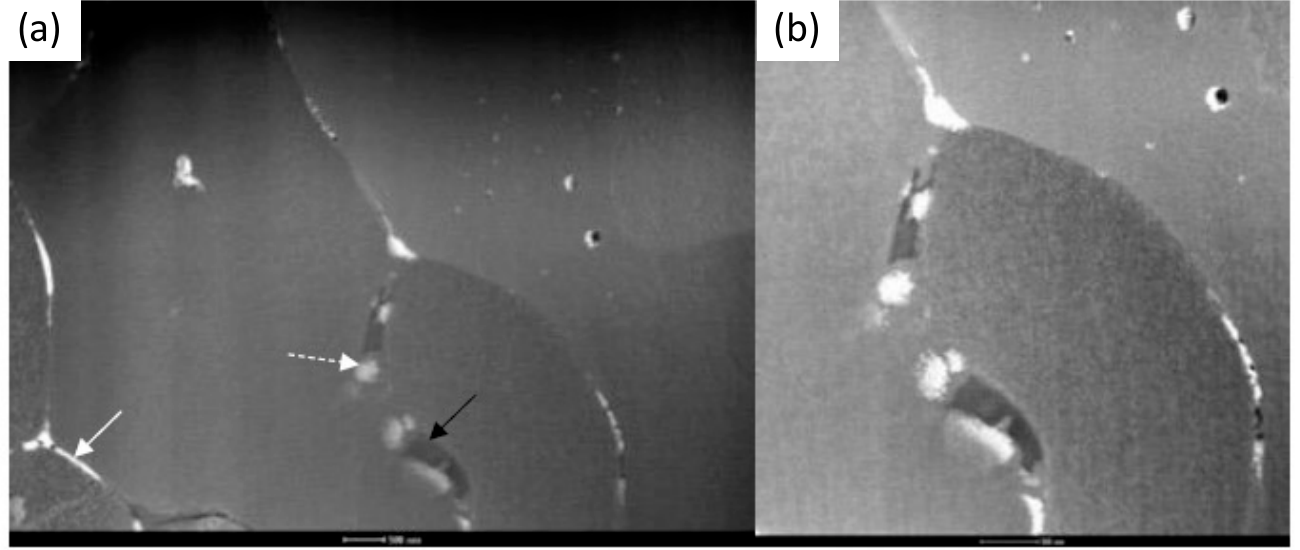
Figure 4. ( a ) presents a STEM micrograph of an as-atomized Al 6061 powder particle showing different precipitates, intermetallic phases, secondary phases, or dispersoids along the rapidly solidified polycrystalline sub-granular boundaries, as identified by the solid black, dotted white, and solid white arrows embedded within the micrograph. ( b ) presents a STEM micrograph of the as-atomized Al 6061 microparticle at a greater magnification such that the proximity between the sub-grain boundaries and the secondary intermetallics located along said sub-granular boundaries. Note that the scale bars affiliated with ( a , b ) are 500 nm. Therefore, the precipitates along the polycrystalline boundaries are 100 nm to 200 nm in size.